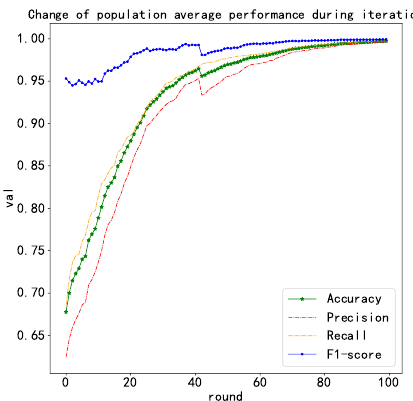
Figure 6. Change in population’s average